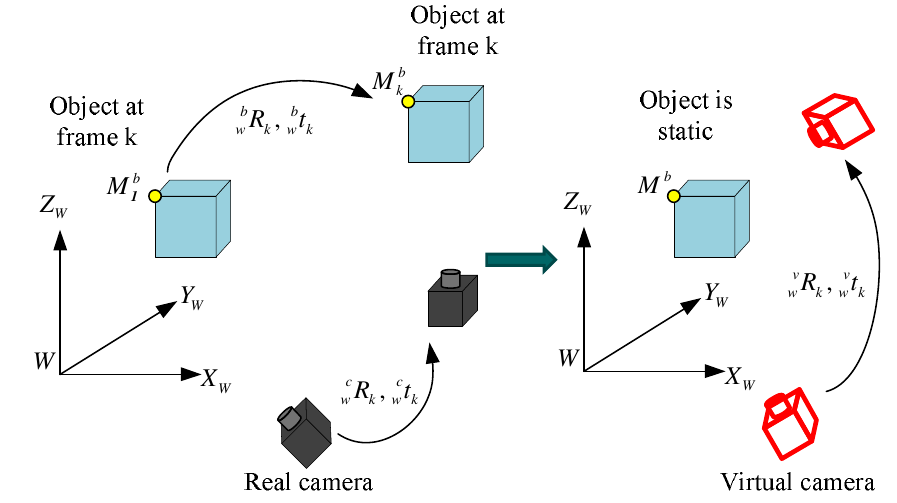
Figure 7. A concept of virtual